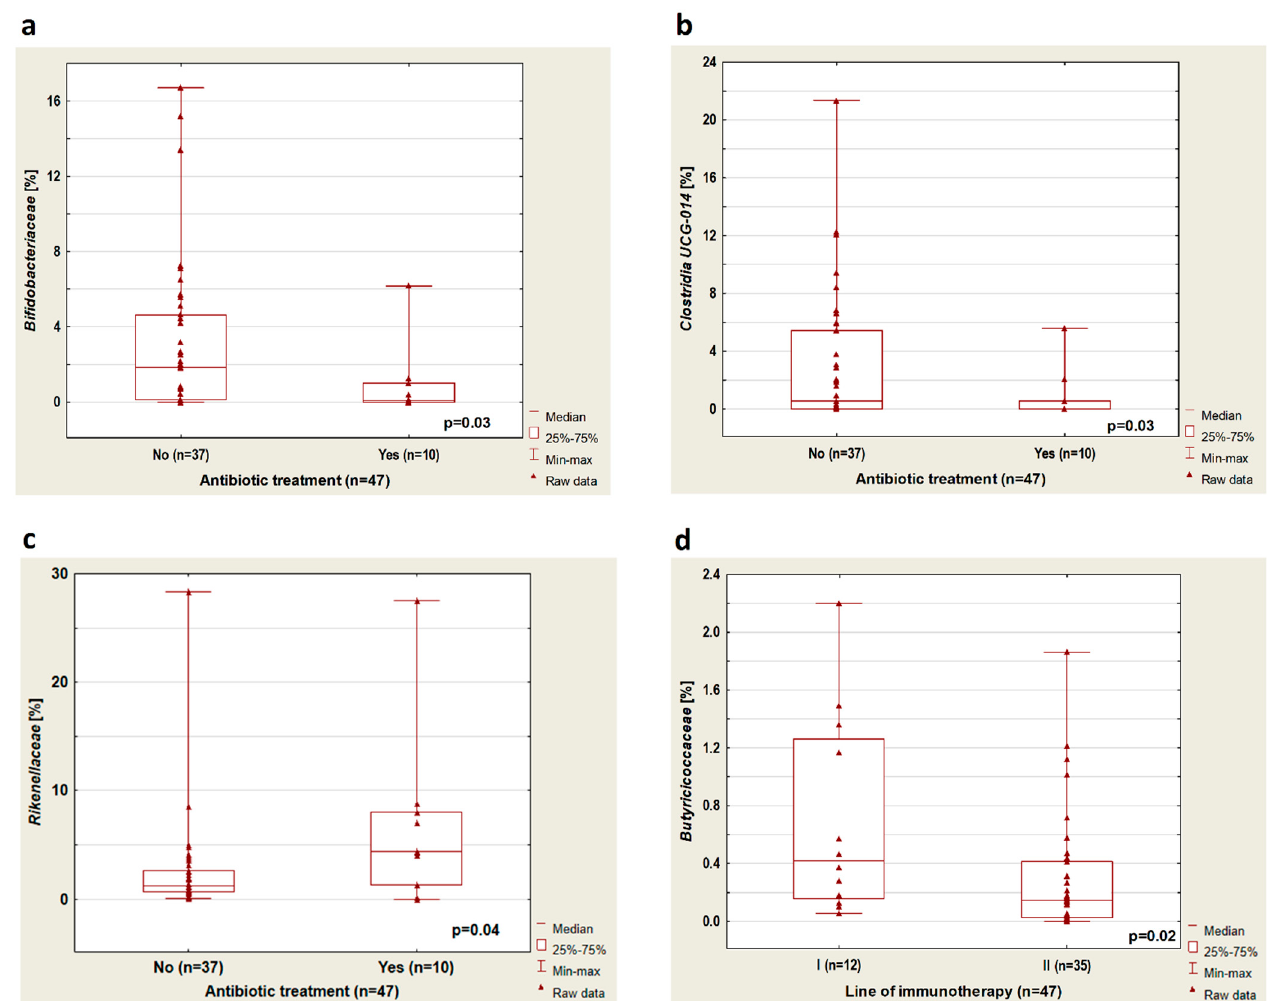
Figure 2. Boxplots showing the content of ( a ) Bifidobacteriaceae , ( b ) Clostridia UCG-014 , ( c ) Rikenellaceae depending on the application of antibiotic treatment, and ( d ) Butiriciococcaceae depending on the line of immunotherapy.